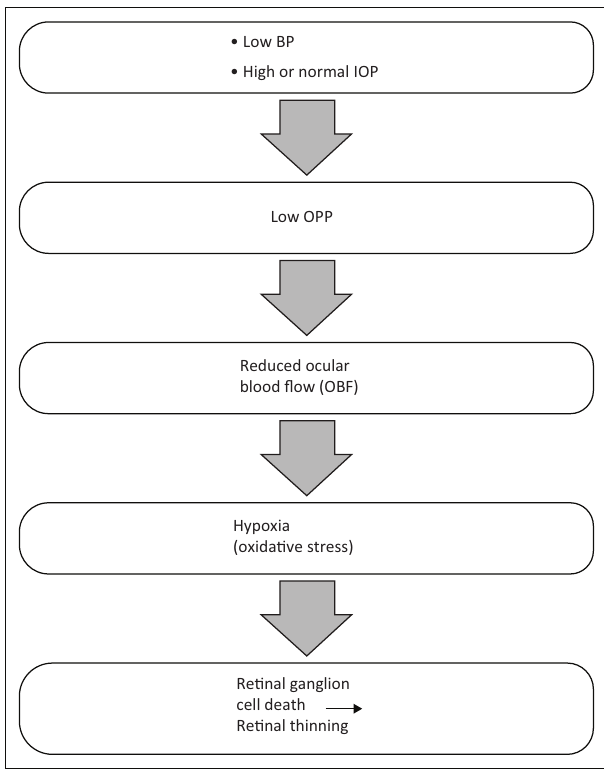
FIGURE 1: The process of reduced ocular perfusion in systemic hypotension.